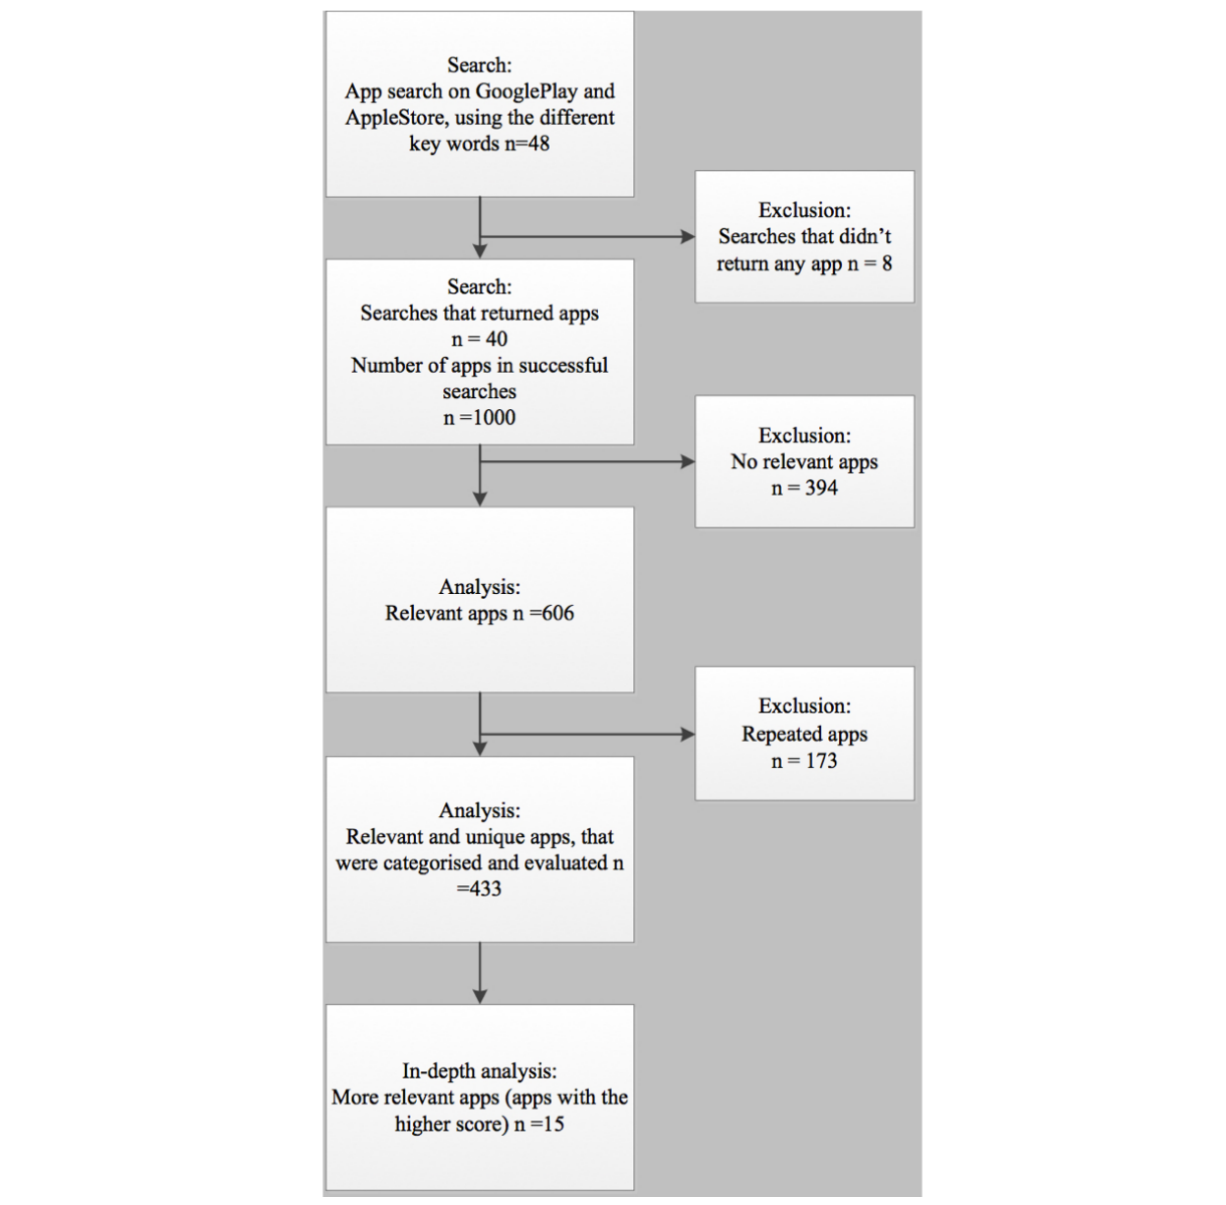
Figure 1. Flowchart management and control of stress-related mobile app